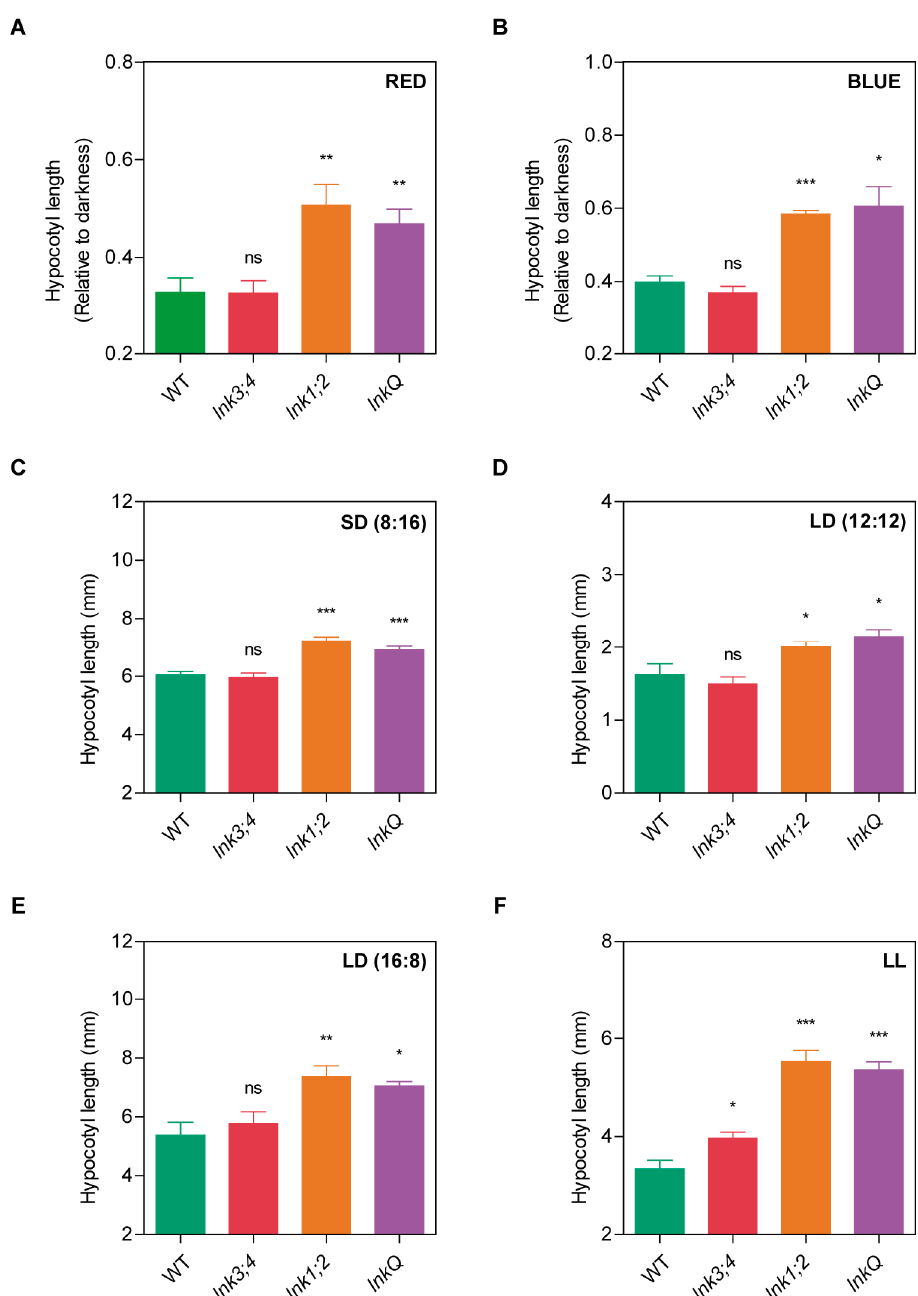
Figure 3. Role of the LNK family in the control of photomorphogenesis. Hypocotyls of WT and LNK mutants grown under different wavelengths and photoperiods; for continuous red and blue light measurements are expressed relative to the dark control; for white light treatments absolute values are displayed. ( a ) Continuous red light (10 µ mol · m − 2 s − 1 ). ( b ) Continuous blue light (2 µ mol · m − 2 s − 1 ). ( c ) Short-day photoperiod in white light (1 µ mol · m − 2 s − 1 ; SD; 8:16). ( d ) 12 h light:12 h dark cycles in white light (1 µ mol · m − 2 s − 1 ; LD; 12:12). ( e ) Long-day photoperiod in white light (1 µ mol · m − 2 s − 1 ; LD; 16:8). ( f ) Continuous white light (1 µ mol · m − 2 s − 1 ). Error bars indicate SEM. Student’s t -test was performed between mutants and WT (*: significantly different, p ≤ 0.05; **: significantly different, p ≤ 0.01; ***: significantly different, p ≤ 0.001; ns: not significant).